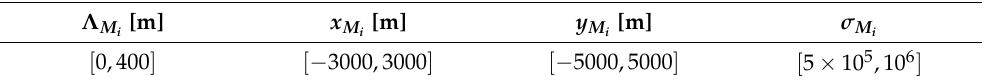
Table 4. Parameters of mountainous